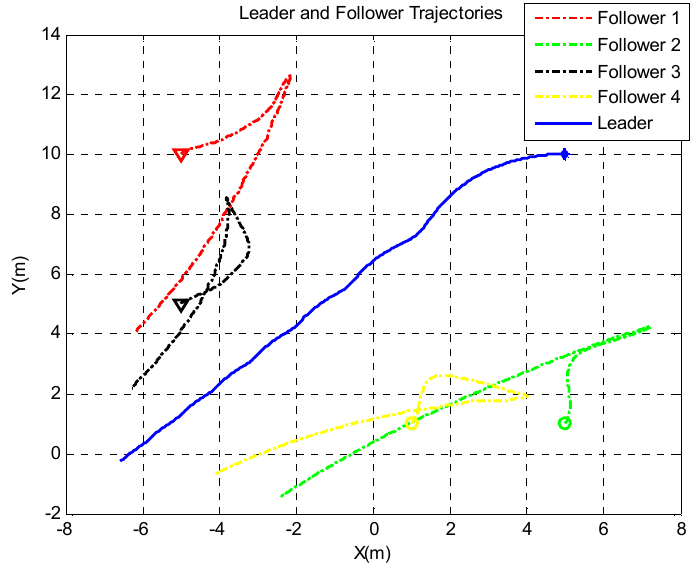
Figure 11. Leader-follower trajectories in Example 2.